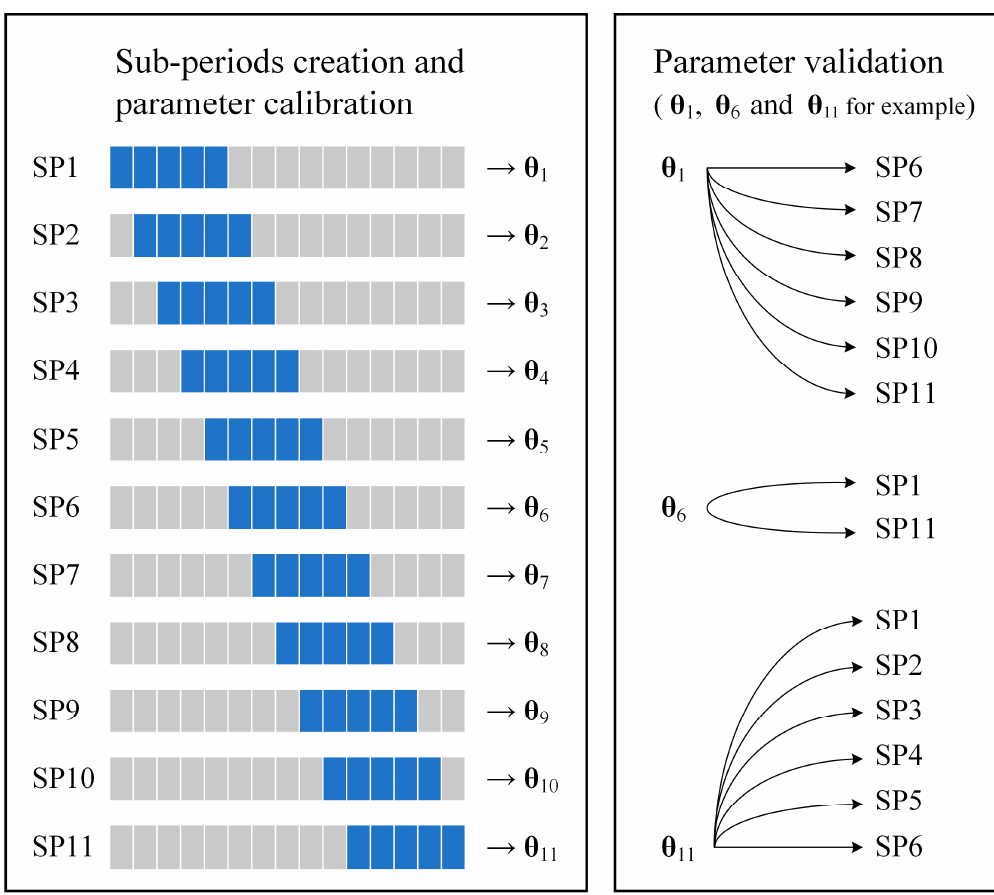
Figure 1. Illustration of the generalized split-sample test (GSST) procedure (example with 15 years available and 5-year subperiods). (Adapted from the work of Coron et al. [40]).